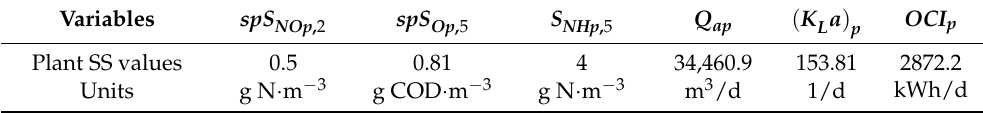
Table 3. Plant steady-state optimization results.